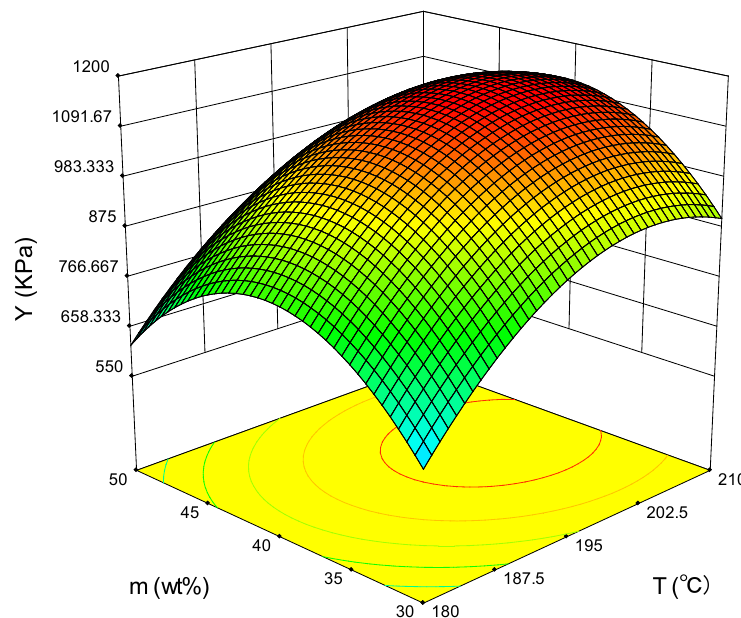
Figure 4. Response surface showing Y as a function of curing agent dosage (m) and treatment temperature (T).